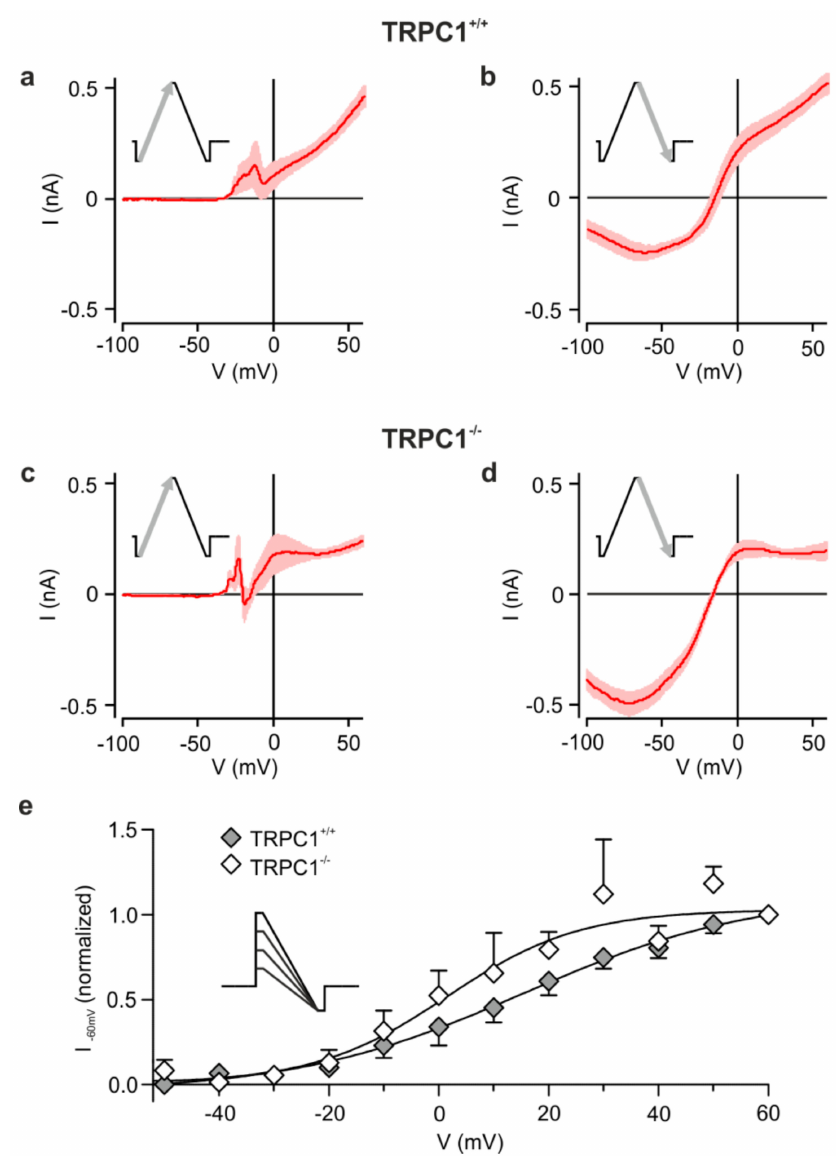
Figure 3. Voltage dependence of mGluR I-activated currents. ( a , c ) Mean IV relationships of the DHPG-activated current obtained from voltage ramps from − 100 to + 60 mV in TRPC1 +/+ and TRPC1 − / − neurons. ( b , d ) Response from the same neurons as in (a, c) to a ramp from + 60 to − 100 mV. Ramp responses were recorded in TTX. Results are means ± SEM with n = 6 ( TRPC1 +/+ ) and n = 10 ( TRPC1 − / − ). ( e ) E ff ect of step potential on the DHPG-sensitive current at − 60 mV. Currents at − 60 mV were measured during ramps to − 100 mV from di ff erent potentials (see inset), normalized to the current following a step to + 60 mV and plotted against the initial potential for TRPC1 +/+ (filled symbols) and TRPC1 − / − (open symbols). Values are the means of 4–18 experiments, with the exception of the values at − 50 mV for TRPC1 +/+ ( n = 2) and at + 50 mV for TRPC1 − / − ( n = 3). The continuous curves are fits of the average data to a Boltzmann equation (Equation 1) with respective V 1 and z values of 15.5 mV and 1.2 for 2 TRPC1 +/+ and 1.5 mV and 2.1 for TRPC1 − / −